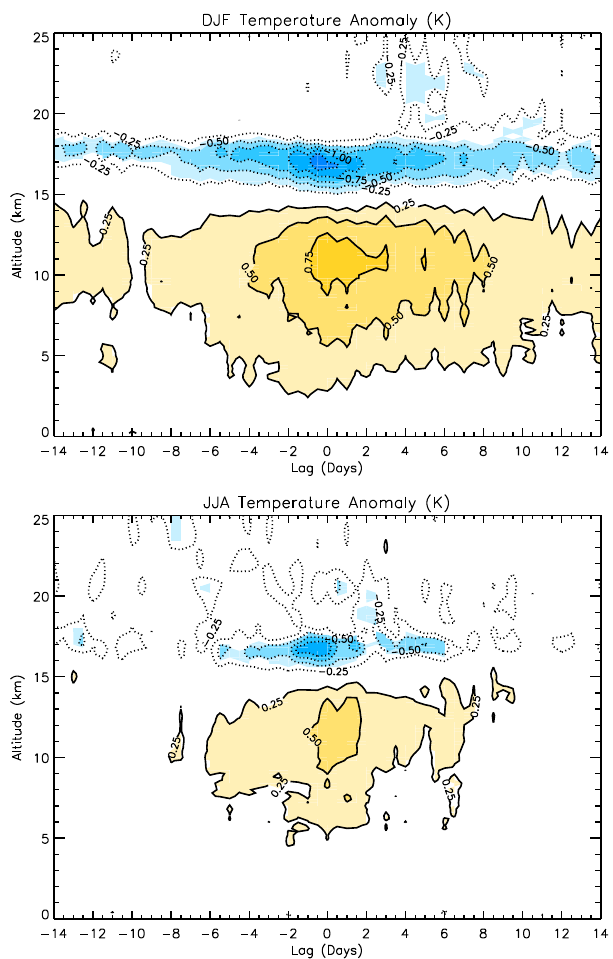
Fig. 8. Temperature anomaly within 1000 km of a deep convective cloud with cloud top greater than 17 km, contoured as a function of time and altitude during (top) DJF and (bottom) JJA. The contour interval is 0.25 K, and anomalies that exceed the 99% significance level appear in color. Orange and red colors correspond to positive anomalies, blue colors correspond to negative anomalies.